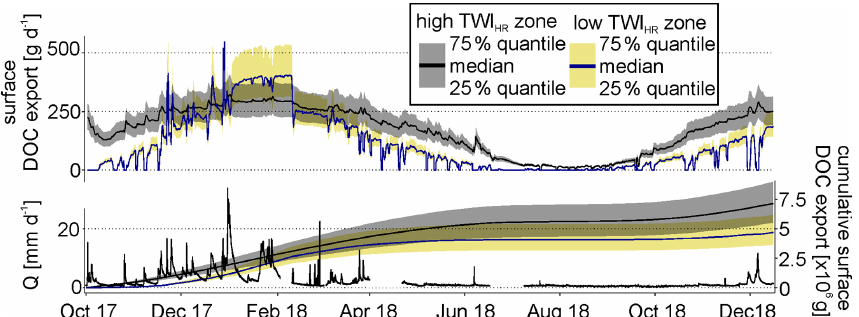
Figure 7. Absolute DOC surface export (25th, 50th and 75th percentiles) from high-TWI HR (DOC I quality) and low-TWI HR (DOC II quality) source zones. Underlying DOC concentration percentiles based on all riparian groundwater samples of each source zone. Cumulative positive DOC export (25th, 50th and 75th percentiles) from high- and low-TWI HR zones are shown on the second y axis. Discharge rate ( Q ) (lower black line) is shown on the lower left vertical